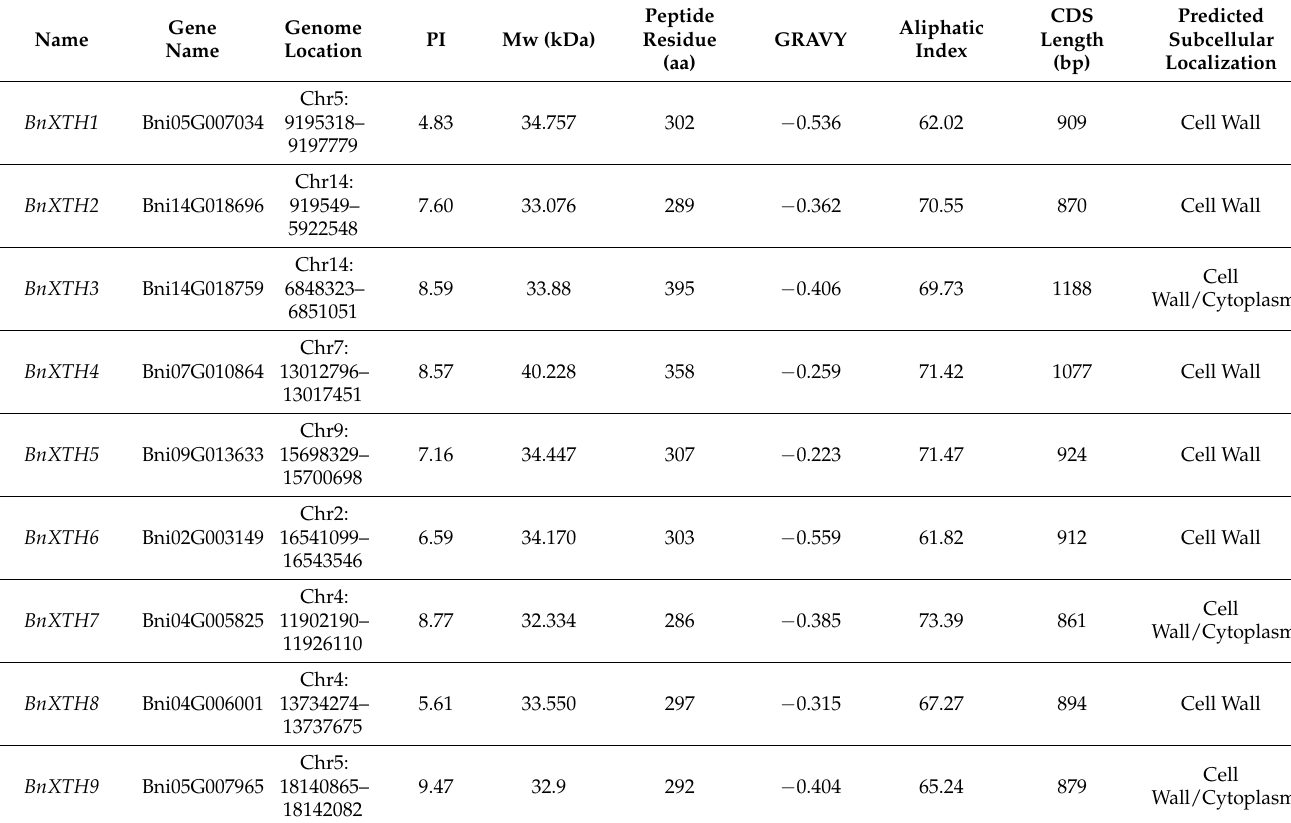
Table 1. Molecular characterization of BnXTH